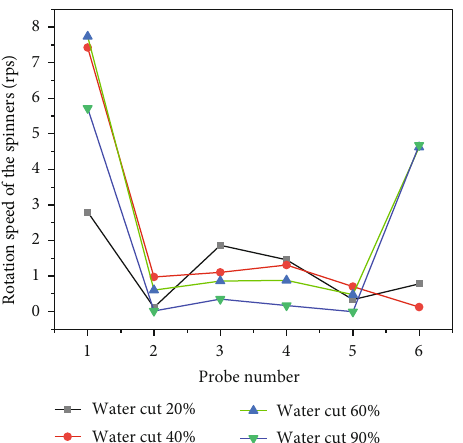
Figure 16: The response diagram of SAT spinners with flow rate = 100 m 3 /d in horizontal well in di ff erent water cuts.